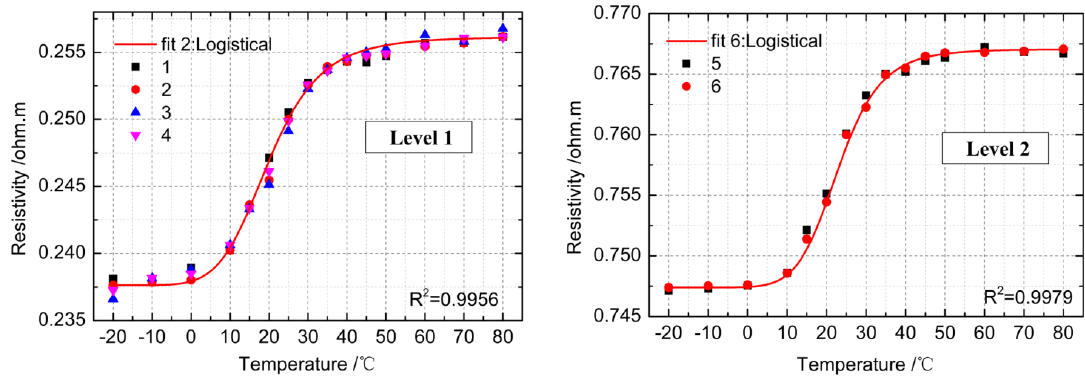
Figure 9. Variations of block resistivity ρ with temperature 𝑇 on side A of 4.5 Ah cell with nearly SOC of 100%. All data in the graphs are the average of ten independent measurements. The dotted lines are the logistical fit to the representative blocks discussed in Section